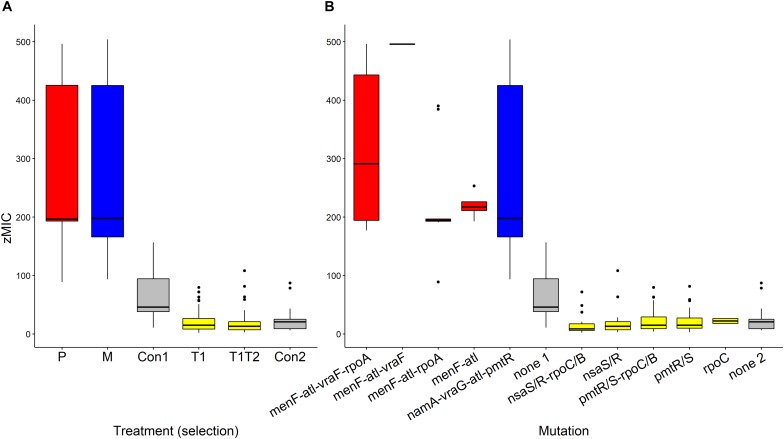
Estimated pharmacodynamic MIC (zMIC) of AMP-selected versus AMP-sensitive S. aureus segregated by treatment (A) or by mutation (B). (Con: passaged non-selected control for pexiganan- and melittin-selected lines (Con1, none1, gray) and for tenecin-selected lines (Con2, none2, gray), P: pexiganan-selected S. aureus (red) segregated into 4 genotype variants with mutation in menF, atl, and vraF, rpoA or both, M: melittin-selected S. aureus (blue) with mutation in namA, vraG, atl, and pmtR gene loci,T1: tenecin 1-selected S. aureus (yellow) and T1T2: tenecin1 + 2-selected S. aureus (yellow) harboring a mutation in either pmtR/S or nsaS/R gene loci which might be accompanied by a mutation in rpoC/B). The boxplots show the first to the third quartiles and the median. The bars indicate the 1.5 interquartile of the lower and upper quartiles. The dots represent outliers.